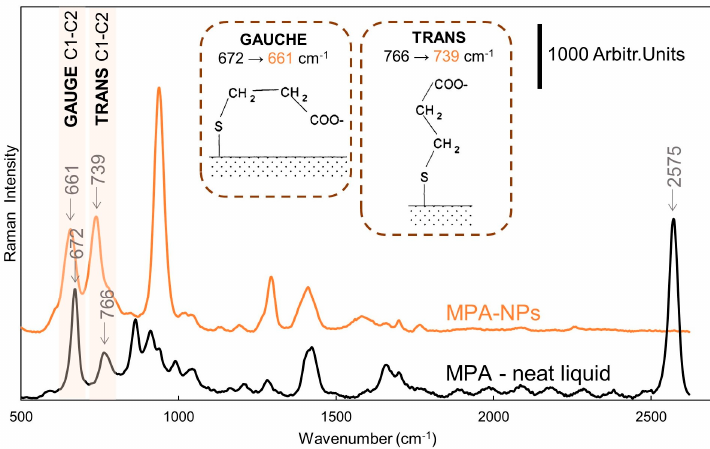
Figure 2. Comparison of the Raman spectrum of the MPA (neat liquid) and SERS spectrum of nanoparticles modified by MPA (0.5 mg / mL). The accumulation time was 3 × 15 s and 3 × 5 s, respectively. For a better visual comparison of the spectra, an o ff set, background correction, and smoothing was